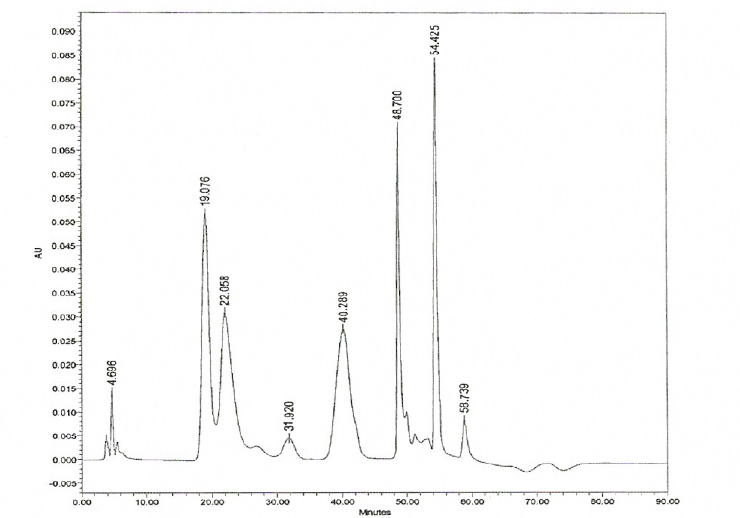
Figure 1. HPLC chromatogram of mixture of eight standards in gradient elution with one mg.mL -1 concentration.